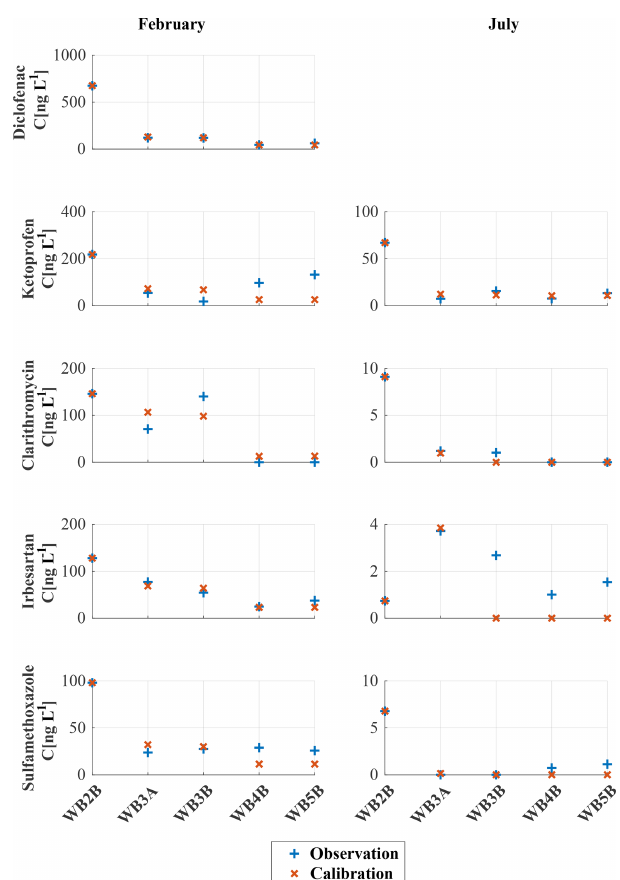
Figure 3. Concentrations of five selected pharmaceuticals for both winter and summer campaigns. Red crosses represent modeling re- sults obtained with model M3, whereas blue plusses represent mea- sured concentrations at the five selected locations along the Noce River. Diclofenac was detected only during the winter